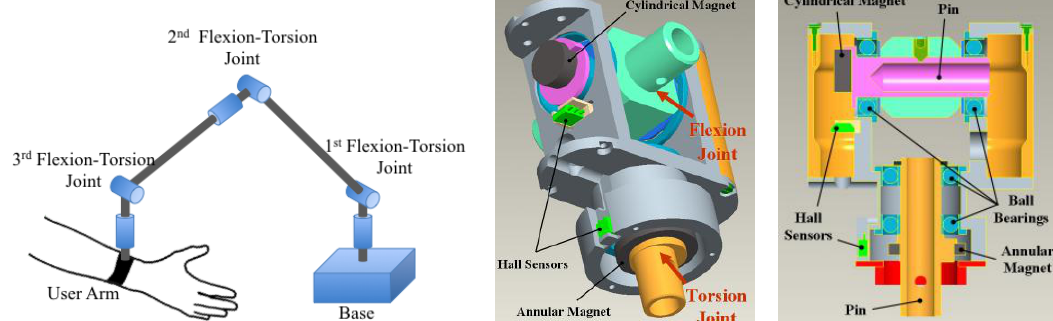
Figure 11. CAD models of the implementation of the Flexion-Torsion joint equipped with two different sensor developed with annular and cylindrical magnet. An equivalent solution has been employed for the